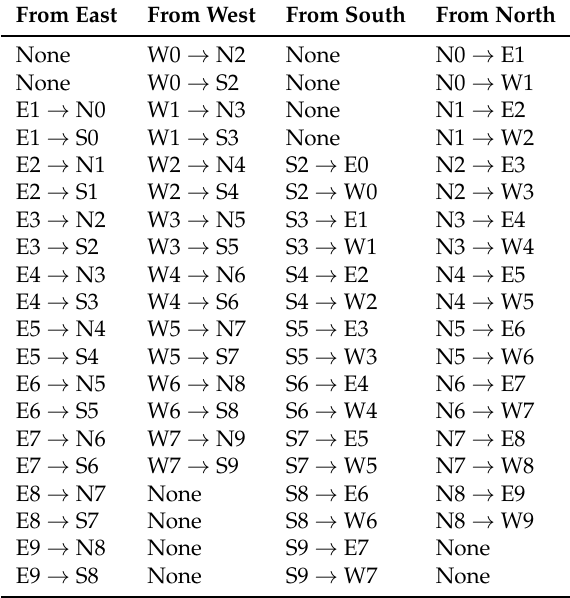
Table 3. PIPs in the oblique direction in one XC4VLX60